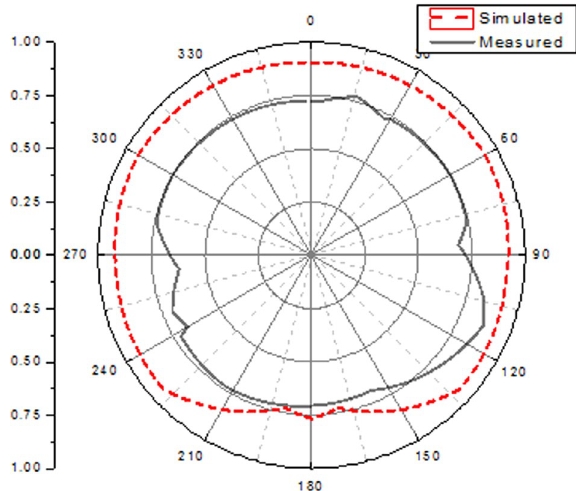
Fig. 10 Fidelity factor variation